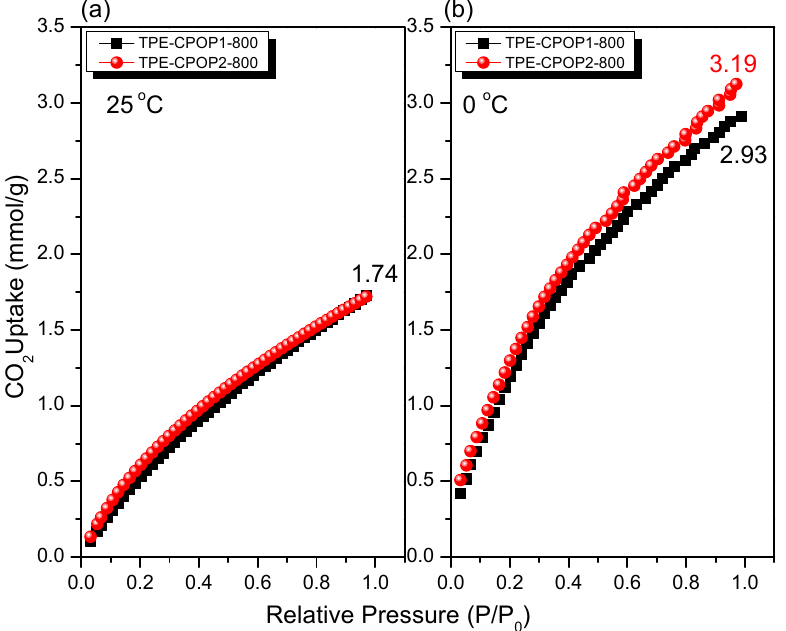
Figure 10. CO 2 uptake of TPE-CPOP1-800 and TPE-CPOP2-800 at 25 °C ( a ) and 0 °C ( b ).